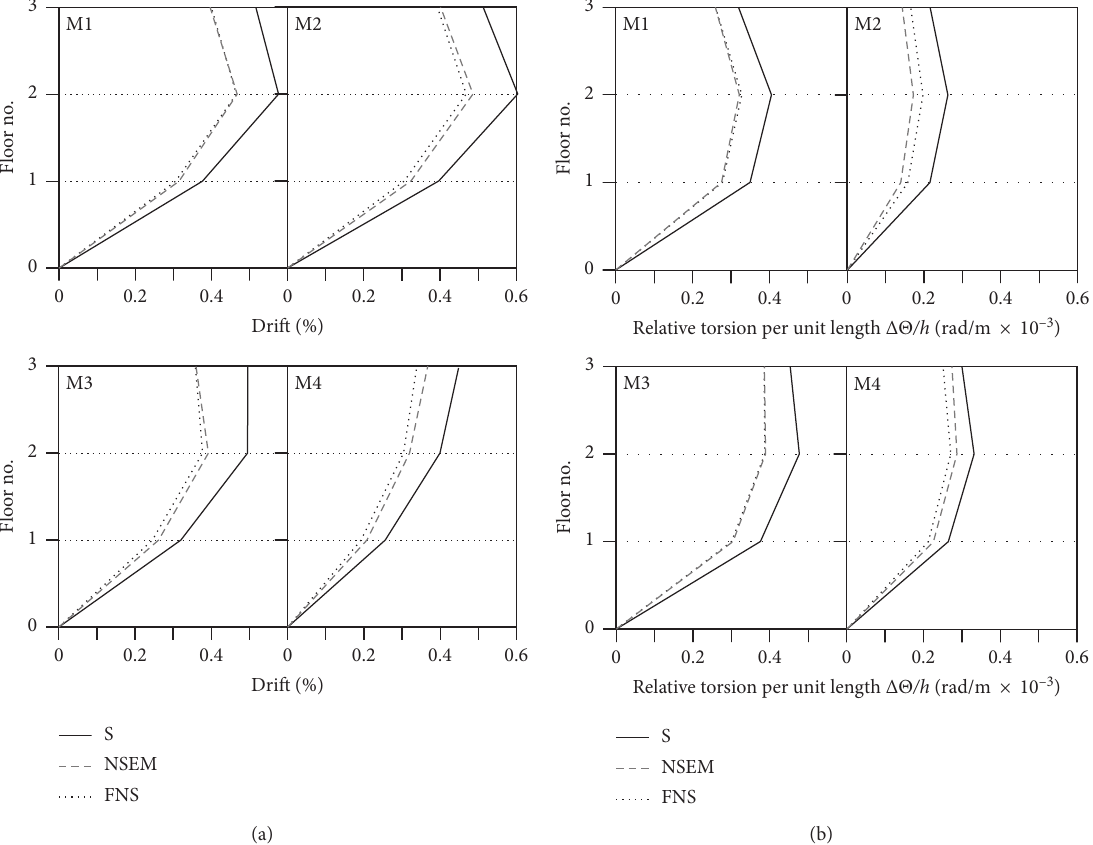
Figure 6: Average interstorey drift (a) and relative torsion per unit length (b) of M1, M2, M3, and M4 structural models obtained from three sets of the considered artificial